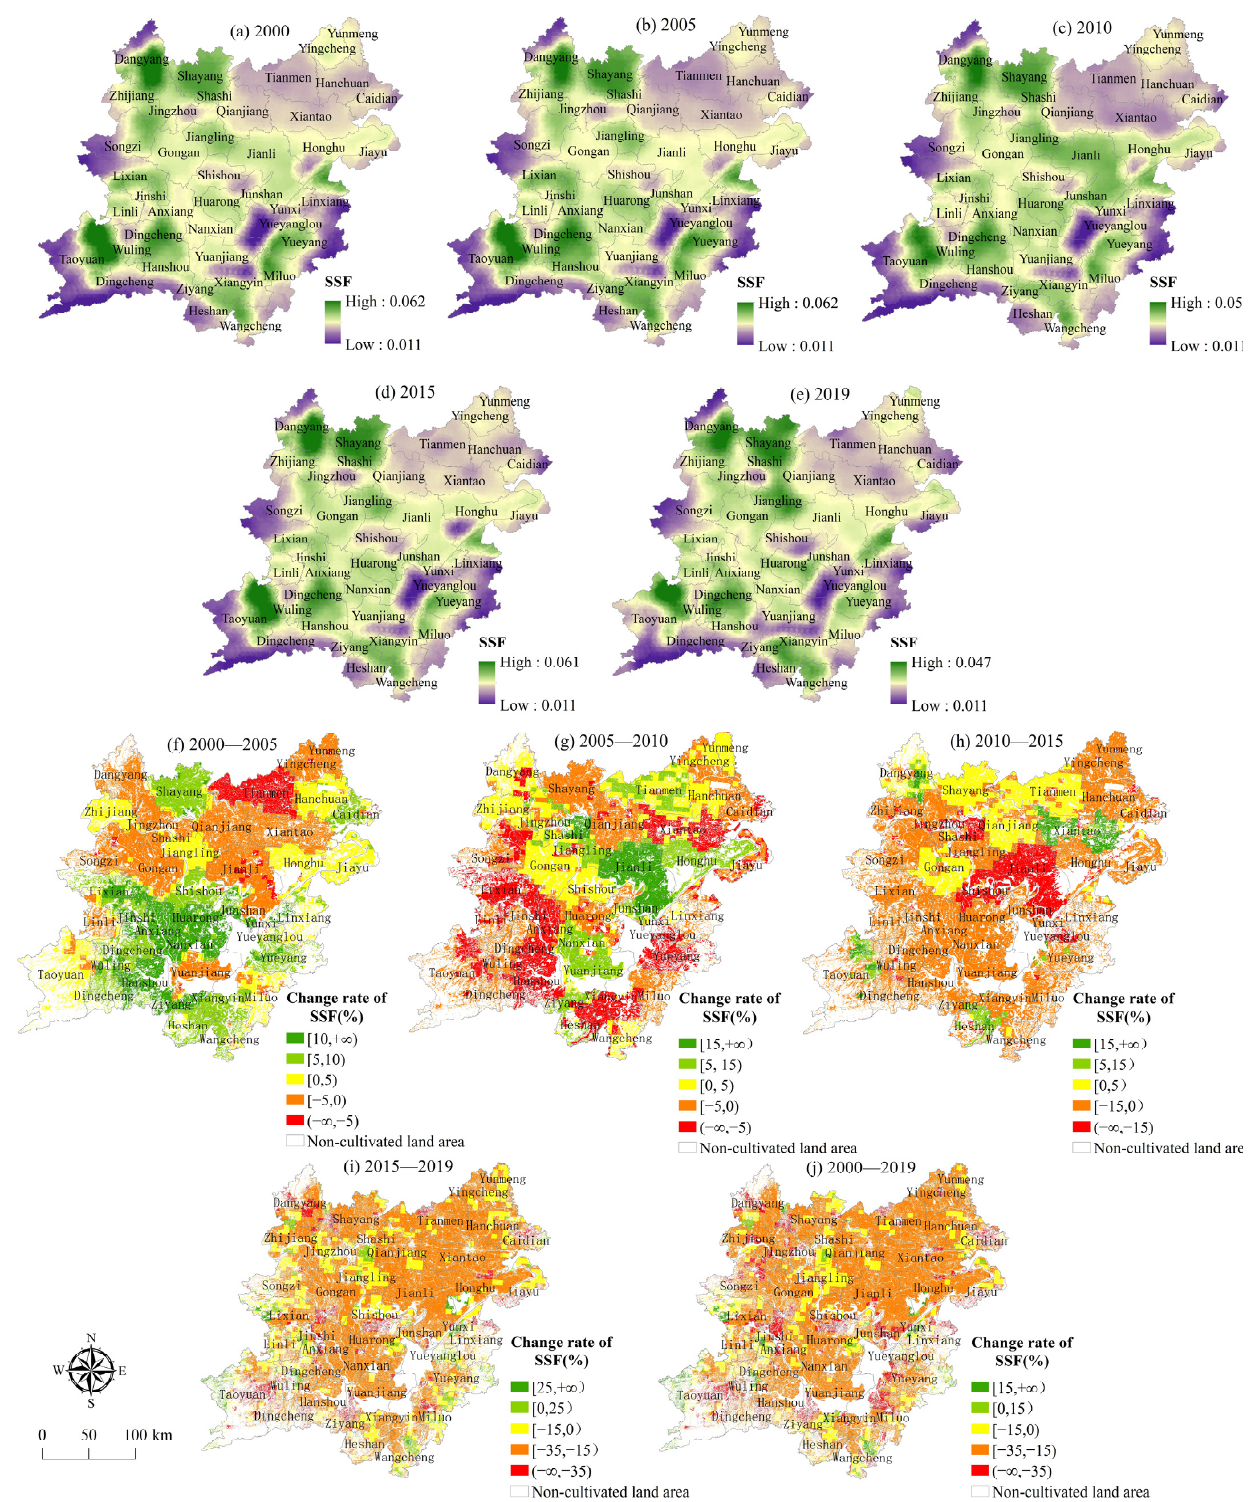
Figure 8. Spatial distribution of the social security function index.